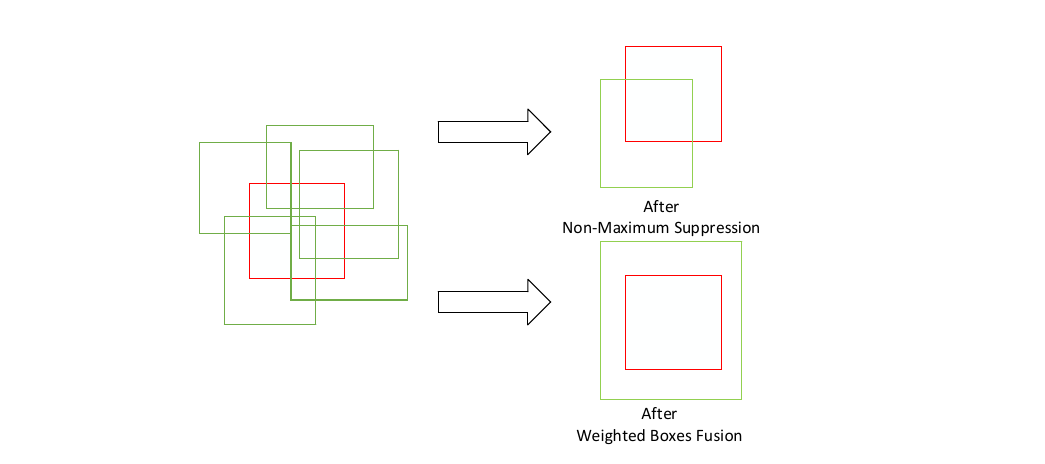
Figure 8. Detection results were obtained by using different non ‐ maximum suppression algorithms.